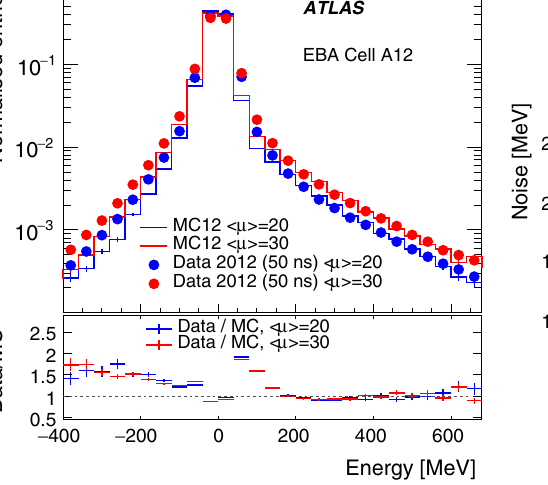
distribution in all A-layer cells, as a function of (cid:4) μ (cid:5) (right) for data